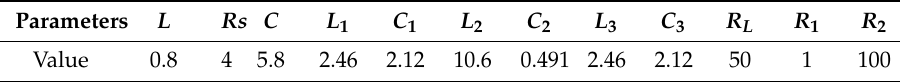
Table 2. Electrical parameters of the proposed CSMN.